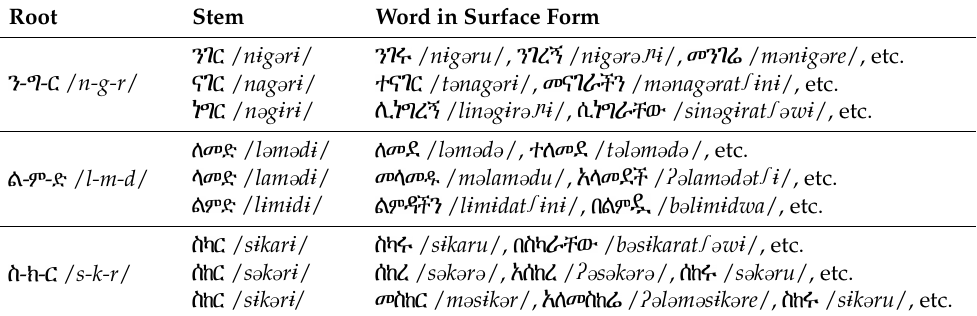
Table 1. Stem and word formation.